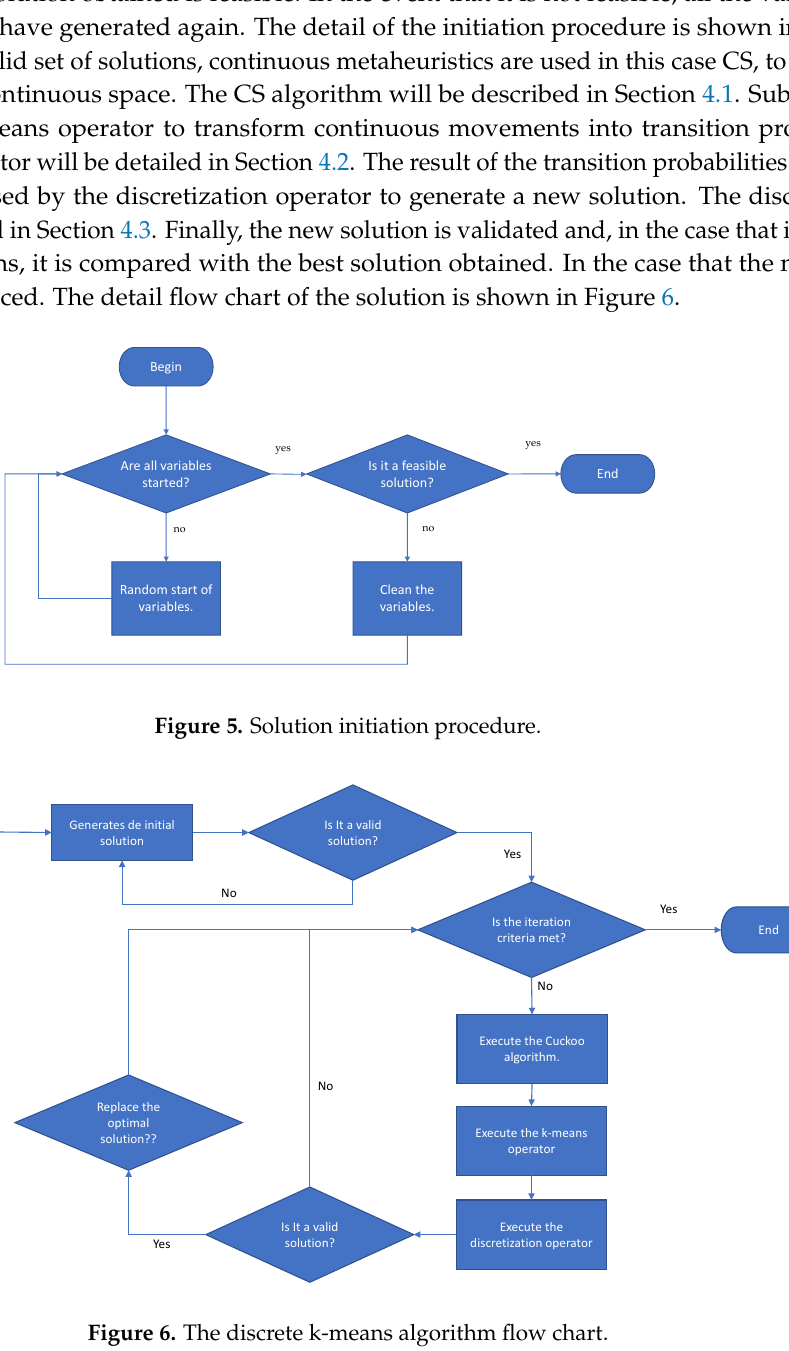
Figure 6. The discrete k-means algorithm flow